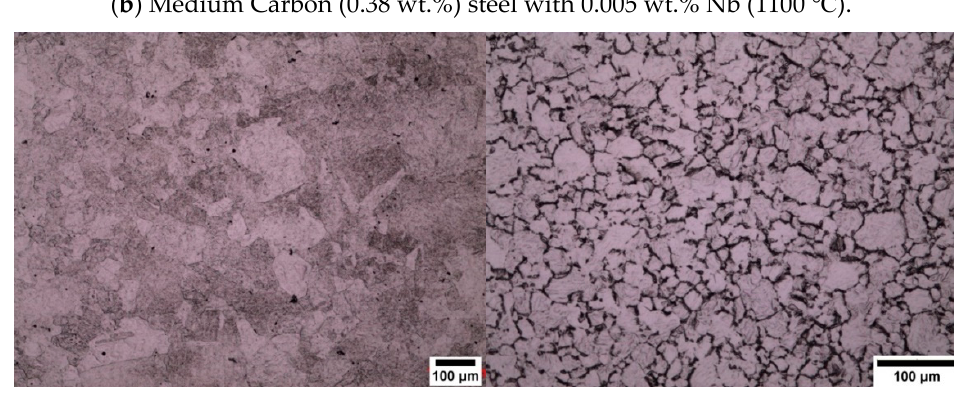
Figure 2. Steel specimens etched with saturated picric acid with different wetting agents. Sodium alkylate sulfonate (Teepol) in the left-hand column, ( a – c ), Sodium dodecyl sulfate (SDS) in the right-hand column ( a , b ), and Sodium dodecylbenzene sulfonate (SDBS) in the right-hand column ( c ).